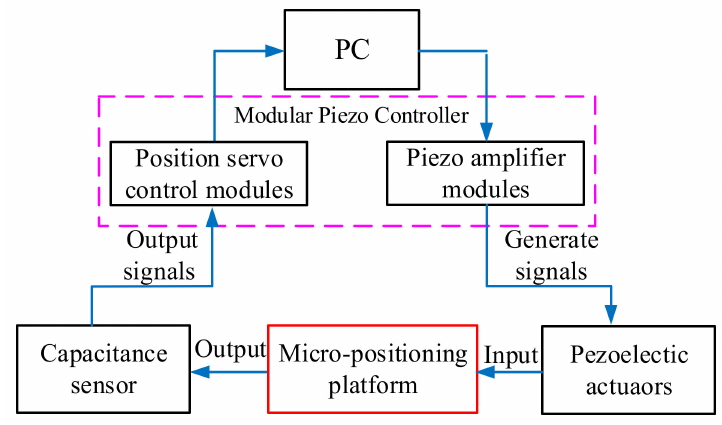
Figure 6. Experimental test